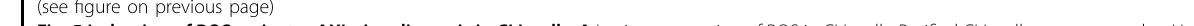
Fig. 5 Induction of ROS activates AXL signaling axis in CLL cells. A In vitro generation of ROS in CLL cells. Puri fi ed CLL cells were exposed to H 2 O 2 (0.6mM) for 5 min or left untreated. Cells were analyzed for ROS generation by fl ow cytometry after staining the cells with DHE to detect O 2 − generation or DCFDA to detect H 2 O 2 accumulation. Results of ROS accumulation in CLL cells from a representative CLL patient is shown. B ROS generation increases tyrosine phosphorylation levels. Puri fi ed CLL cells ( n = 5; P1 – P5) treated with H 2 O 2 as described above were lysed and tyrosine- phosphorylated proteins were immunoprecipitated from the cell lysates using a phospho-tyrosine (4G10) antibody, followed by western blot analysis using the same antibody. C Enforced induction of ROS activates AXL. CLL cell lysates (P1 – P5) used in panel B were analyzed to detect AXL phosphorylation levels by immunoprecipitating AXL, followed by western blot using 4G10. The blot was stripped and reprobed with an antibody to AXL. IgG heavy chain (HC) was used as loading control. D Impact of ROS accumulation on other RTKs. CLL cell lysates (P1 – P5) used in panels B , C were further analyzed to detect the activation status of multiple RTKs including FGFR (a downstream target of AXL), IGF1R β and c-MET in western blots using phospho-speci fi c antibodies. Respective blots were stripped and probed with a speci fi c antibody to FGFR3, IGF1R β , or c-MET, and used as loading controls. Densitometric analysis was performed to detect “ fold activation ” of FGFR (P-FGFR: FGFR3). E Status of SIRT3 and SOD2 expression in H 2 O 2 -exposed CLL cells. The above CLL cell lysates were further analyzed for the expression of SIRT3 and SOD2 in western blots using speci fi c antibodies. Actin was used as loading control. Densitometric analyses were performed to determine the expression levels of SIRT3 (SIRT3: actin) and SOD2 (SOD2: actin), and presented as “ fold-expression ” relative to the basal level the value of which was arbitrarily taken as “ 1 ” . The dotted line indicates basal levels (bottom panel). F Enforced induction of ROS does not activate BCR signal. Puri fi ed CLL cells used above (P2 – P5) were treated with ibrutinib (0.75 µM) for 1 h prior exposing the cells to H 2 O 2 as described above for 5 min or left untreated/unexposed. Cell lysates were analyzed for the activation of BTK (as an indicator for BCR signal activation) in western blots. The blots were stripped, probed for BTK and used as loading control. Further, phospho-tyrosine proteins were immunoprecipitated from the above cell lysates (P3, P4), followed by western blot analysis to detect activation of AXL using a speci fi c antibody. IgG HC was used as loading control (bottom panel). G Impact of ROS-mediated AXL activation on its downstream signal mediators. Finally, H 2 O 2 -treated CLL cell lysates (P1 – P5) used above ( B – E ) were assessed for the activation status of AXL downstream targets, AKT and ERK1/2, in western blots using phospho-speci fi c antibodies. The blots were stripped and reprobed to detect total AKT or ERK1/2. H Targeting AXL inhibits ROS-induced activation of AKT/ERK1/2. Puri fi ed CLL cells (P55 – P57) pretreated with an AXL-inhibitor SGI-7079 at a sublethal dose or left untreated were exposed to H 2 O 2 for 5 min. Cell lysates were examined for the activation status of AKT and ERK1/2 in western blots using speci fi c antibodies. The blots were stripped and reprobed to detect total AKT or ERK1/2. Actin was also used as loading control. I Inhibition of endogenous ROS reduces phosphorylation levels of AKT/ERK1/2. Puri fi ed CLL cells (P55 – P57) were treated with a ROS-inhibitor, Trolox for 4 h. Cell lysates were analyzed for the activation status of AXL downstream signal mediators, AKT and ERK1/2, in western blots using speci fi c antibodies. The blots were stripped and reprobed to detect total AKT or ERK1/2. Densitometric analyses were performed to assess modulation of AKT (P-AKT: AKT) or ERK1/2 (P-ERK1/2: ERK1/2) activation in Trolox treated vs. untreated CLL cells and presented as bar diagrams (right panels). For each sample, the basal level activation was arbitrarily taken as “ 1 ”